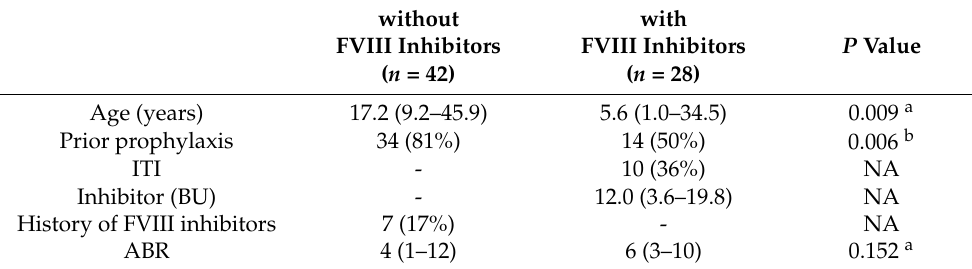
Table 1. Demographic characteristics of patients at study entry.